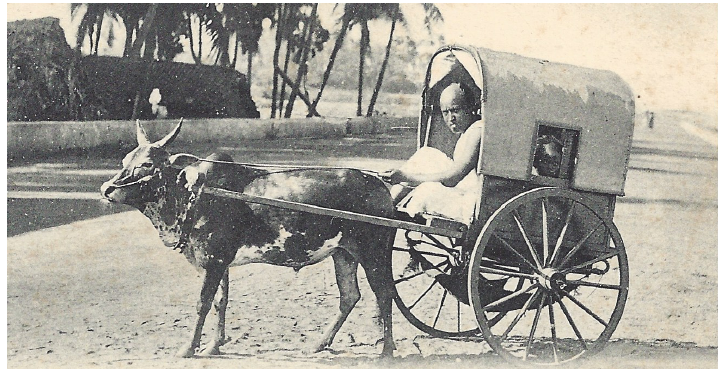
Figure 19. Tamil Nadu dwarf zebu, Madras (postcard, probably from the